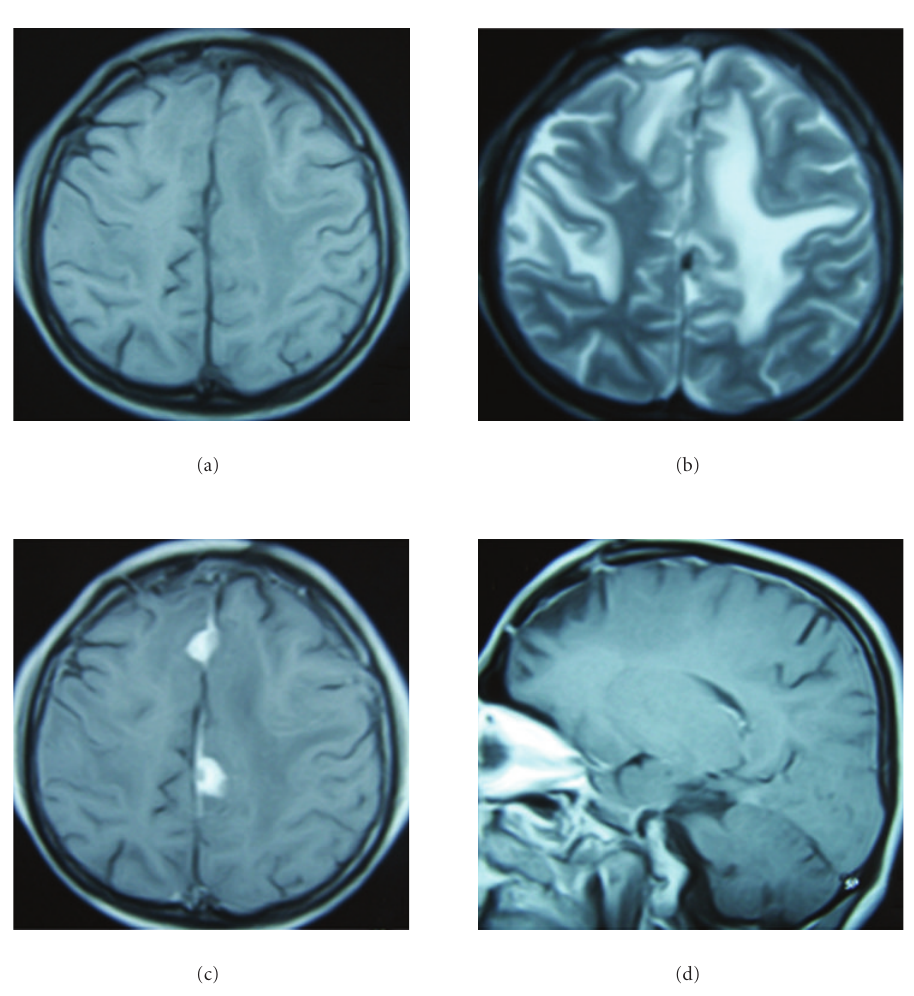
Figure 3: Follow-up MRI at the end of the second postoperative year shows regression of the lesions on unenhanced (a) and enhanced T1-weighted axial (c) and sagittal (d) images with cerebral edema on T2-weighted images